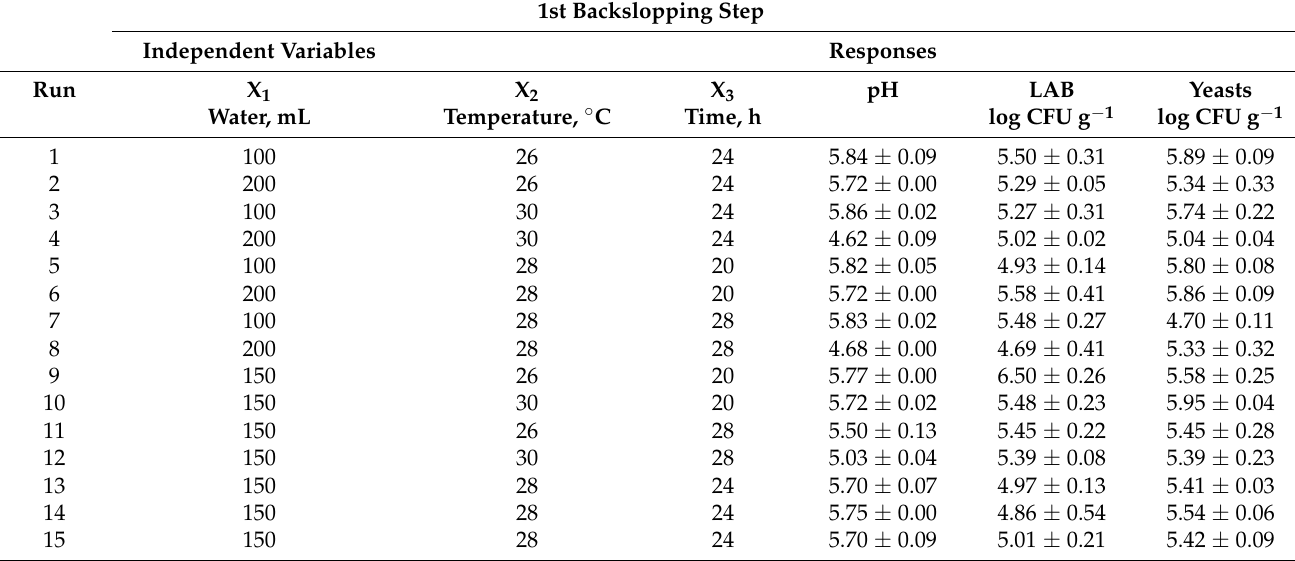
Table 2. The Box–Behnken experimental design and responses data after the 1st backslopping step of fermentation. 1st Backslopping Step Independent